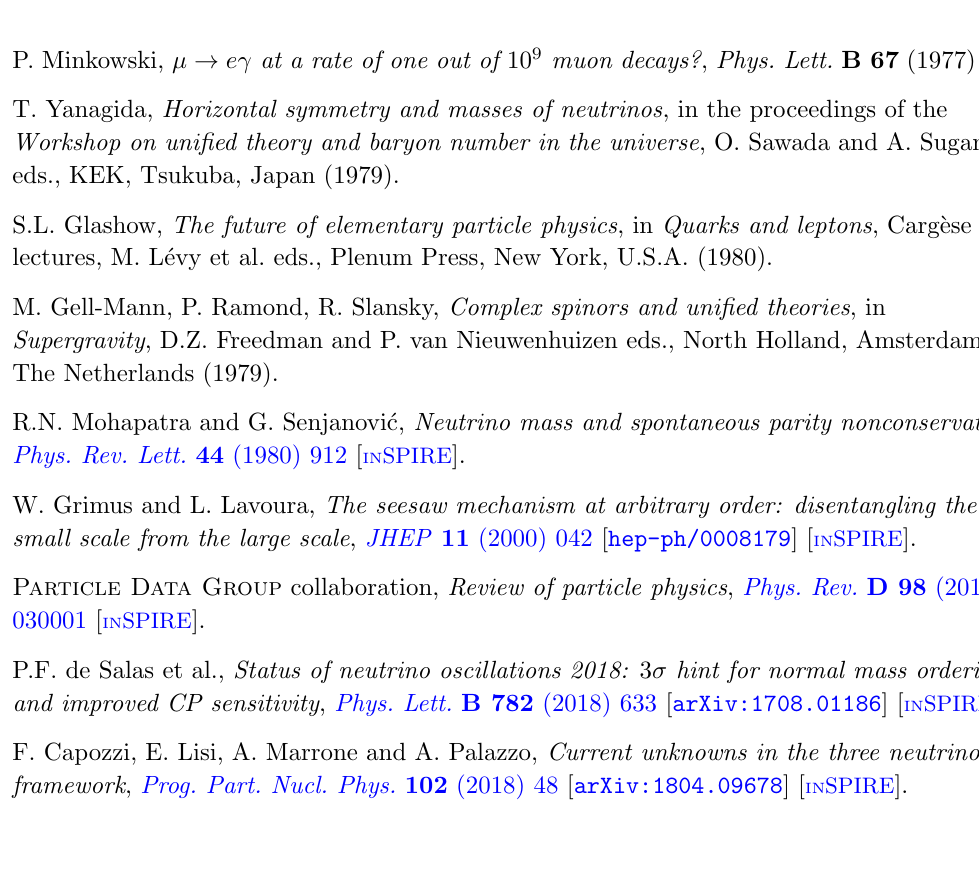
(cid:20) 9. We have included the value (cid:31) 2 = 4 : 71254, obtained minimum (3) , therefore all the (cid:31) 2 are higher minimum minimum